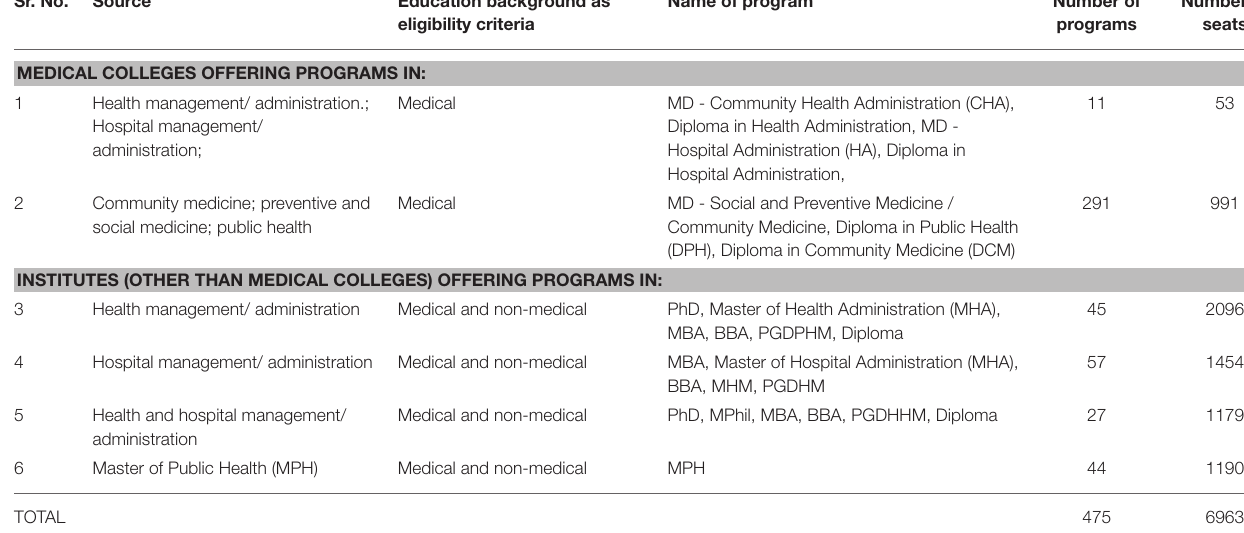
TABLE 1 | Supply of HMPs through medical colleges and institutes [offering health (hospital) management/administration]. Sr. No. Source